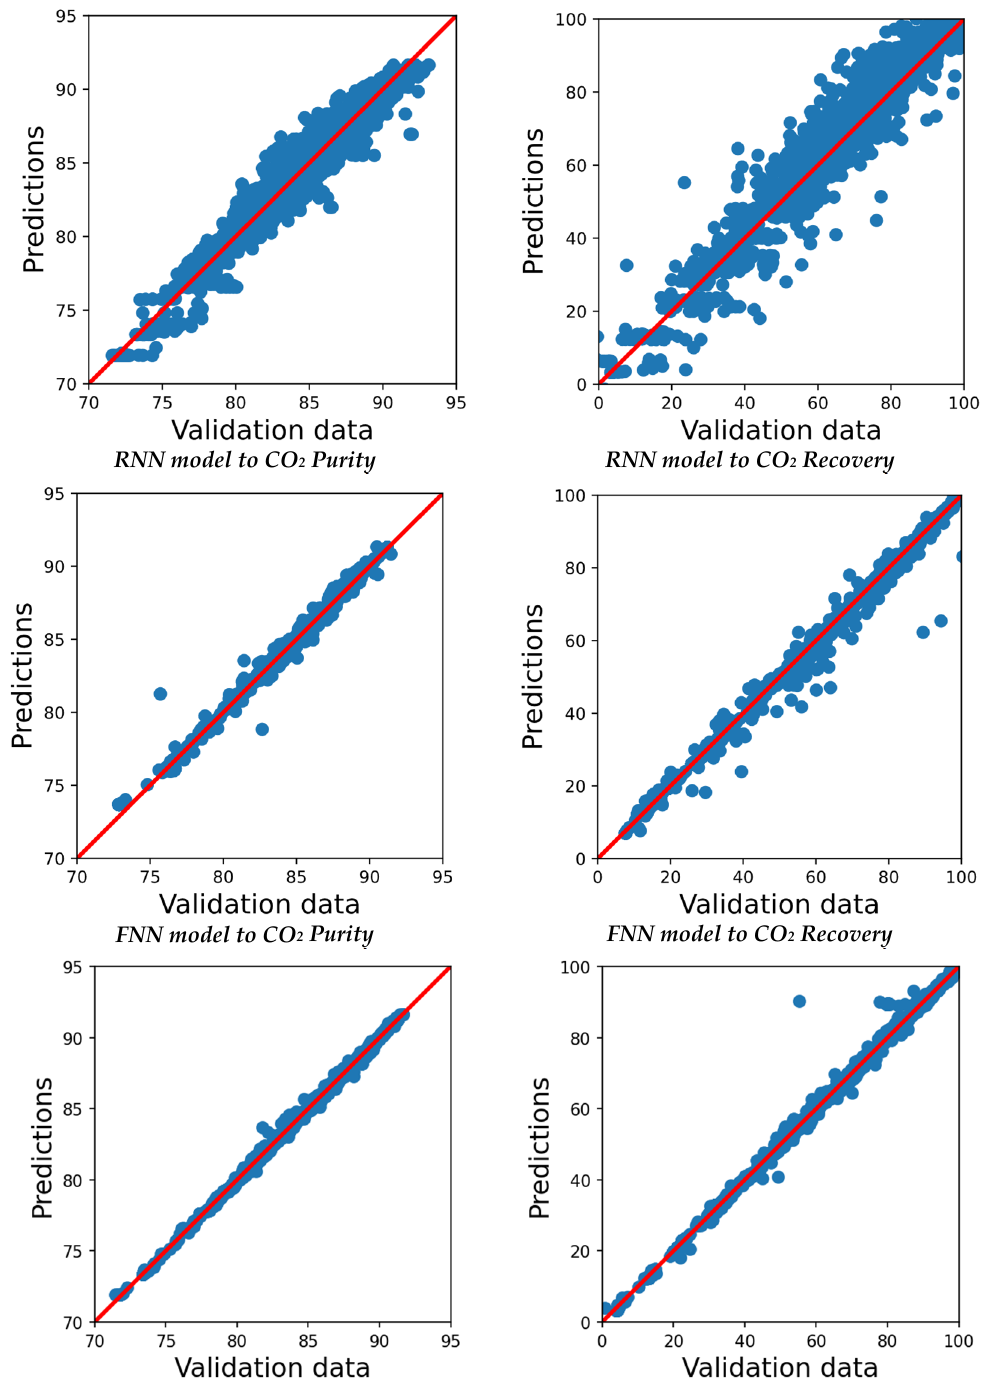
Figure 9. Models’ validation parity graphics.